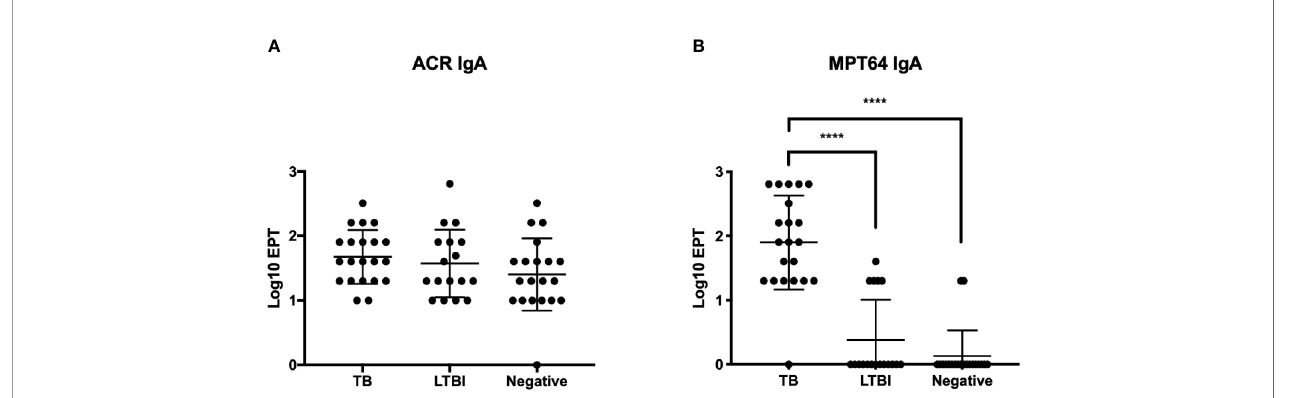
FIGURE 6 | IgA responses in patient serum samples from Instituto Nacional de Sau ́ de, Mozambique. End point titres (EPT) (de fi ned as 2-fold absorbance value of background samples) of IgA in serum against Acr (A) and MPT64 (B) were determined by ELISA with error bars indicating SEM. ****p ≤ 0.0001, one-way ANOVA with Tukey ’ s correction; n = 21 (TB patients), 17 (LTBI), and 19 (BCG vaccinated). Experiment performed once.